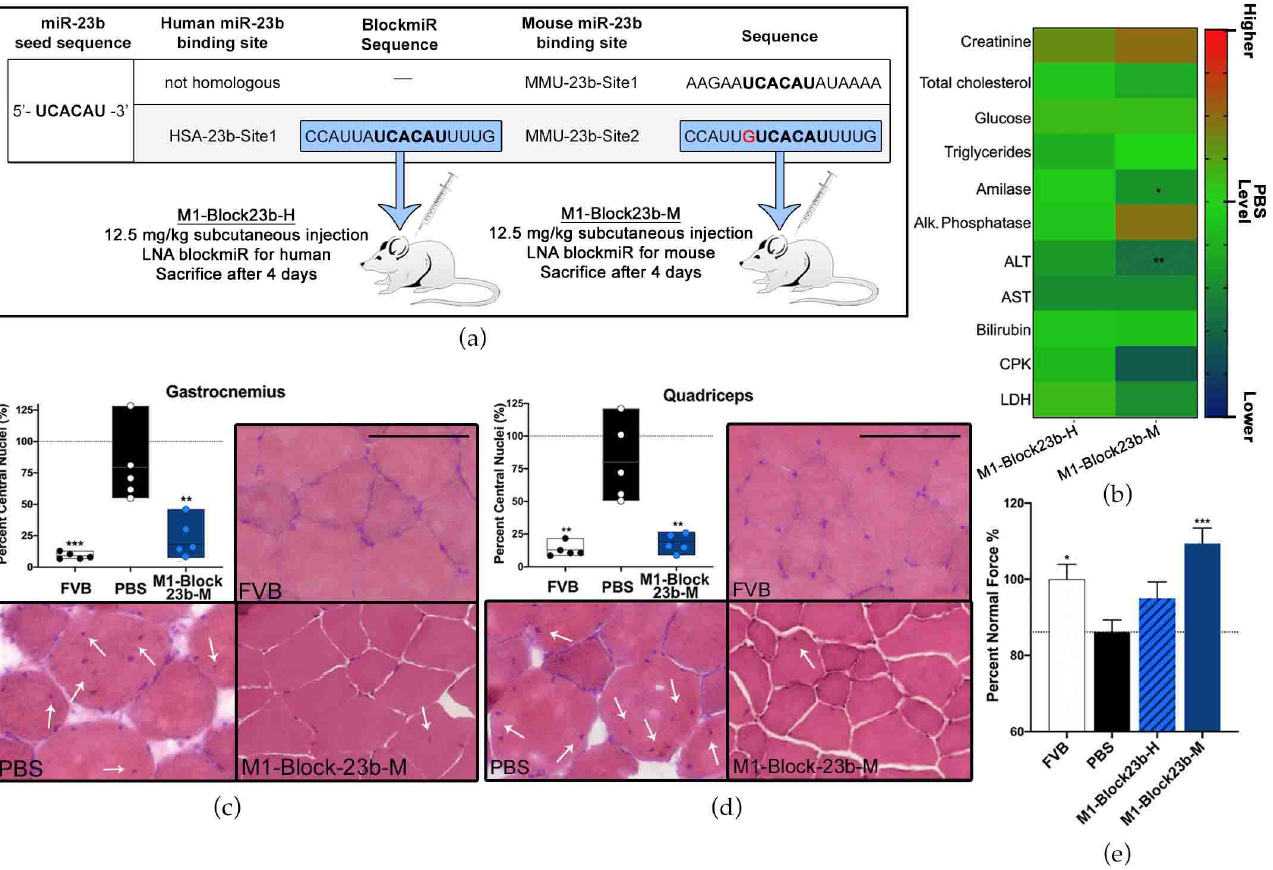
Figure 5. In vivo blockmiR administration is followed by physiological improvements. ( a ) The sequence for the miR-23b binding site targeted in human DM1 cells has one nucleotide difference (red) for the homologous site in mice. Therefore, a new blockmiR was created to account for this single nucleotide difference to facilitate specific binding in HSA LR mice. Both the human and mouse blockmiRs were injected at 12.5 mg/kg into HSA LR mice. HSA LR mice given PBS and healthy FVB mice were used as controls. FVB ( n = 5), PBS ( n = 5), M1-Block23b-H ( n = 5), M1-Block23b-M ( n = 5). ( b ) Toxicological parameters were assessed after treatment and the raw values can be found in Table S4. PBS levels are shown in green. Values above PBS increase to red and values below PBS decrease to blue. All samples are compared to PBS through one-way Kruskal–Wallis ANOVA. ( c ) Gastrocnemius and ( d ) quadricep muscle were cut into 10 µ m sections and stained with hematoxylin and eosin in order to observe the position of nuclei within the muscle fibers. For each mouse, an average of 600 fibers was identified and counted. Representative images of the muscles from each treatment can be seen. Black scale bar = 100 µ m. White arrows indicate nuclei with central localization. ( e ) Mouse grip strength was measured three times both before and after treatment with M1-Block23b-M by grip dynamometer to calculate the percent of normal force normalized to mouse weight. All samples were statistically compared to PBS through Student’s t -test. p -value: p ≤ 0.05 (*), p ≤ 0.01 (**), p ≤ 0.001 (***). Error bars = SEM. SEM and number of fibers for panels ( c , d ) can be found in Table S5. Reproduced/adapted from [29] Universitat de Val è ncia, 2022. The Mbnl1 transcripts were also significantly increased in gastrocnemius and